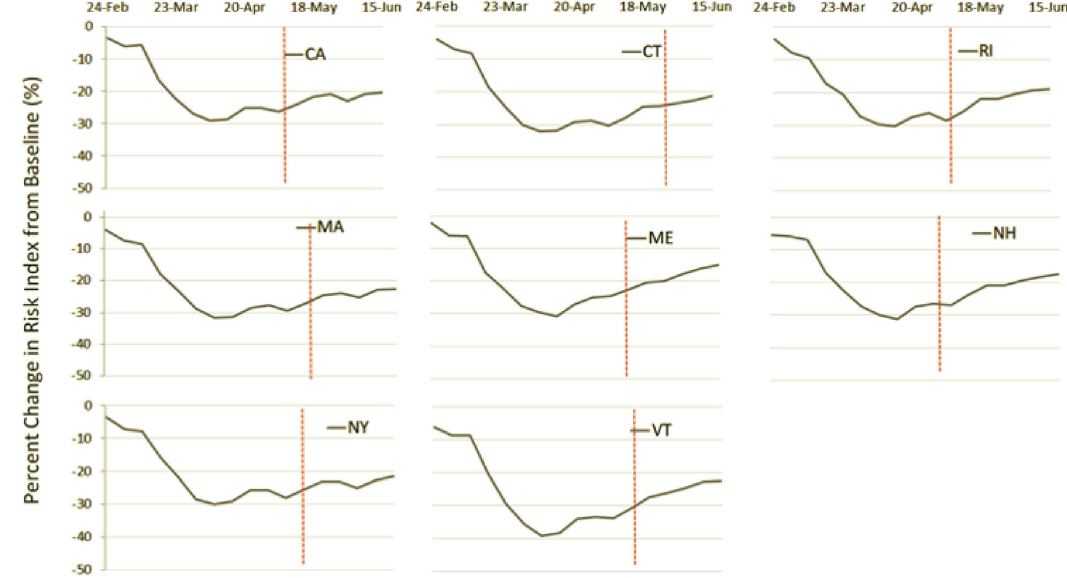
Fig. 2 Percent change in Business Risk Index by states over time from January 2020 to June 2020. Red line indicates Phase 1 reopening date for each